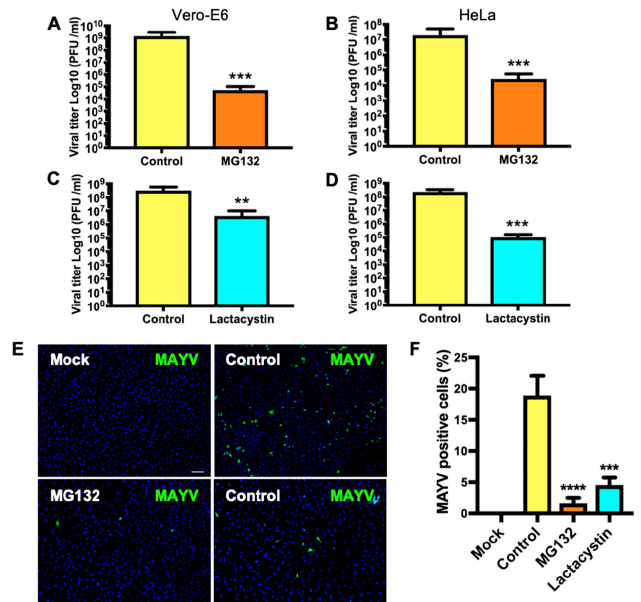
Figure 2. Proteasome inhibition reduces MAYV progeny production. Vero-E6 ( A , C ) or HeLa ( B , D ) cells were pre-treated with 10 μ M of MG132 or 25 μ M of Lactacystin. At 1 h after treatment, the media was removed and the cells were infected with MAYV at an MOI of 1 (Vero-E6) or 10 (HeLa). After 1 h of virus absorption, fresh media supplemented with the inhibitors was added to the cells. In control cells, DMSO (0.1%) or water was added. The production of progeny virus in the supernatants after 24 h of infection was quantified by plaque assay. Viral titers were expressed as plaque-forming units per milliliter (PFU/mL). ( E ) HeLa cells grown onto glass coverslips were treated or untreated with the proteasome inhibitors and infected with MAYV at an MOI of 1. After 24 h of infection, the cells were fixed with 2% paraformaldehyde and stained with a mouse anti-MAYV antibody, followed by an Alexa-Flour 488 anti-mouse secondary antibody. The images were obtained with a confocal microscope and analyzed using ImageJ software. Scale bar, 100 µ m. ( F ) The percentage of MAYV-positive cells following infection of proteasome inhibitor-treated and untreated cells are shown. Statistically significant di ff erences are indicated: ** p < 0.01; *** p < 0.001; **** p <